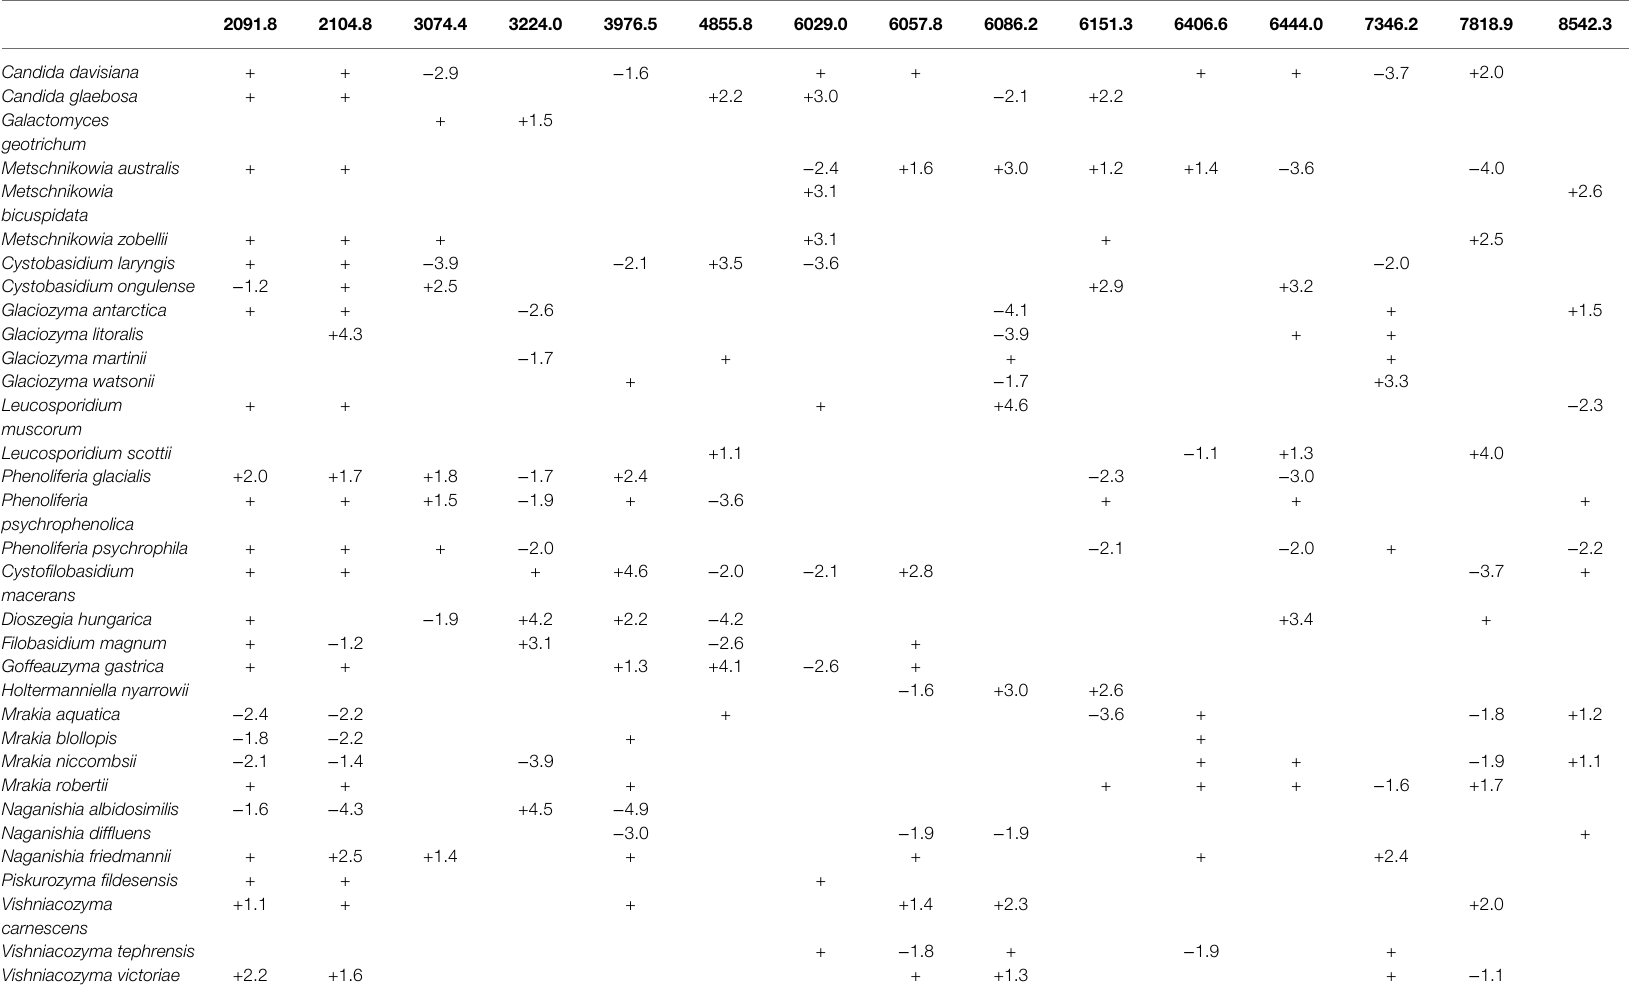
TABLE 2 | Peptide markers of the 33 yeast species from polar